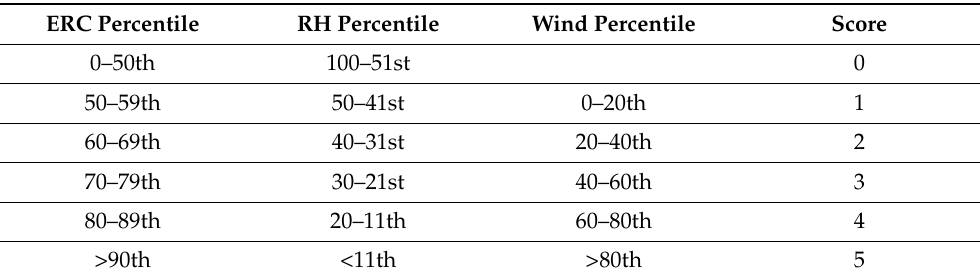
Table 2. Categorical scores for percentiles of ERC, RH, and wind speed. ERC Percentile RH Percentile Wind